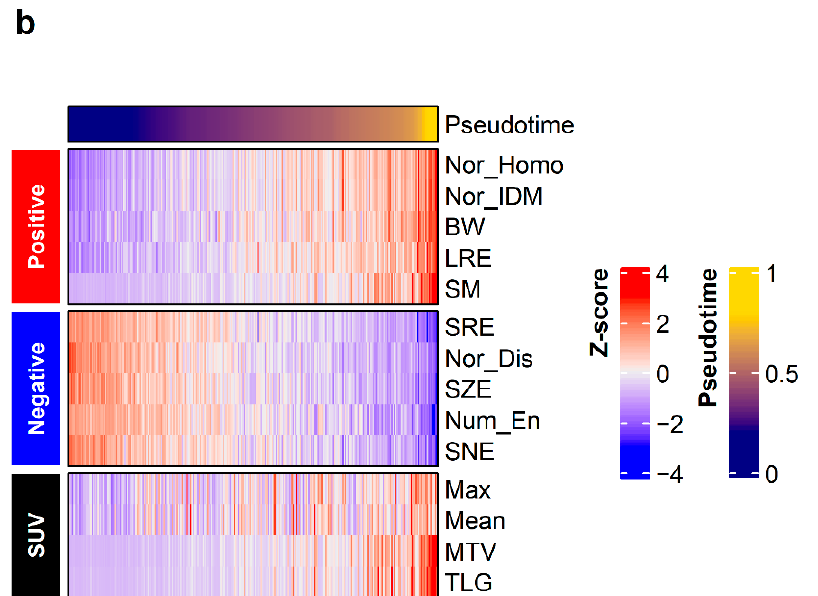
Figure 2. Pseudotime analysis results. Pseudotime of primary tumors was successfully estimated in the radiomics dataset. ( a ) A principal components analysis plot visualized the order of pseudotime in each FDG PET/CT image. Although there was no clustering, pseudotime was estimated according to a specific direction and not randomly. ( b ) The top 10 features demonstrating positive correlations and top 10 features demonstrating negative correlations with pseudotime are shown. Conventional image parameters based on SUV are also shown.